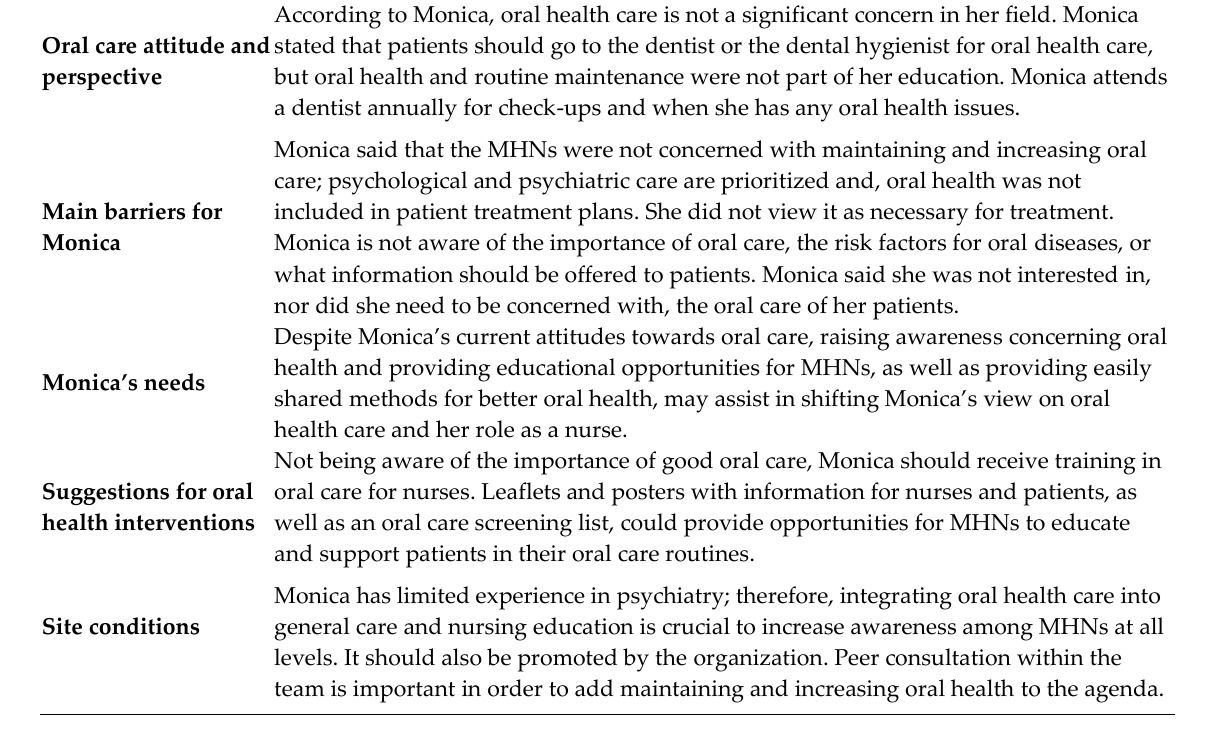
Figure 3. Persona Monica.